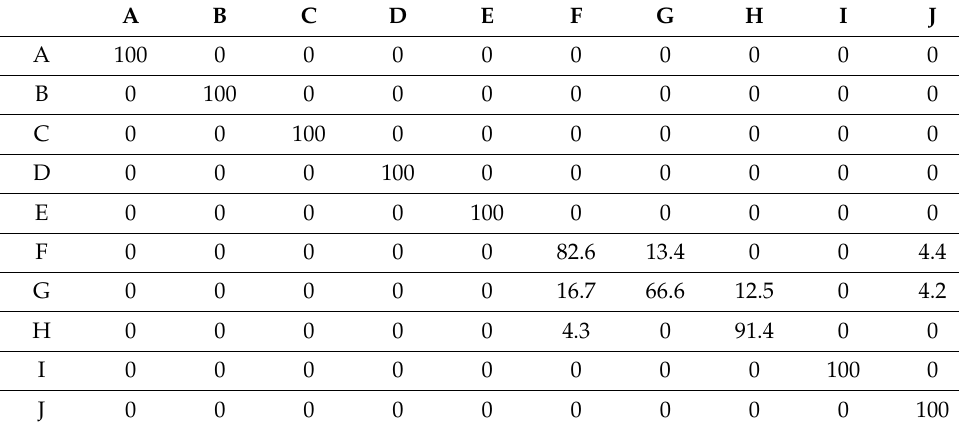
Table 3. Confusion matrix achieved by the classification model applied to all accessions of set 1 evaluated together. All values are expressed in percentage (%). Samples are indicated as follows.